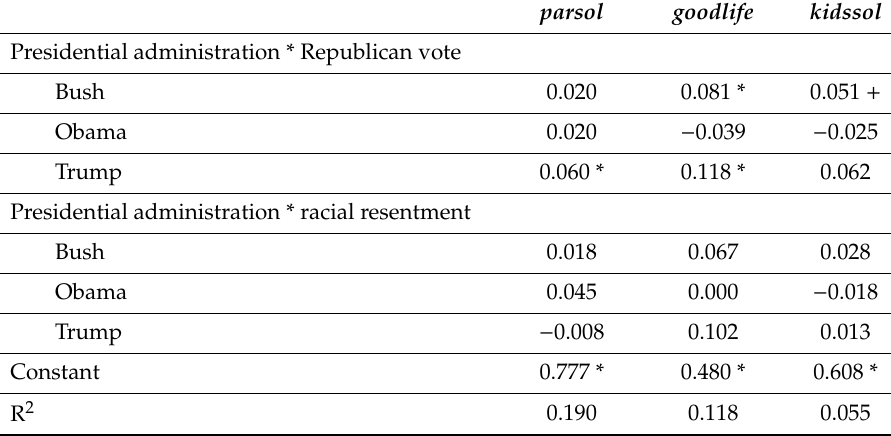
Figure 3. Racial resentment among White respondents, by presidential administration and last presidential vote. Confidence intervals are at the 95% level.